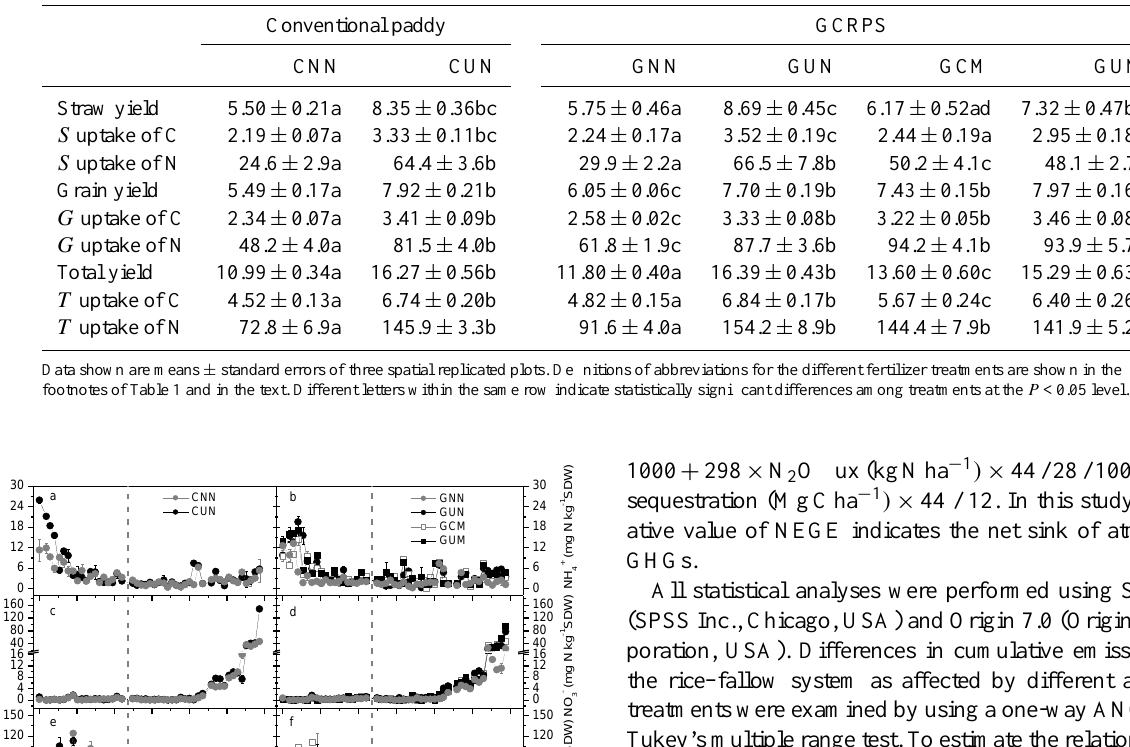
Table 2. Straw ( S ) and grain ( G ) yields as well as total ( T ) yields (straw and grain, in Mgha − 1 ) , and plant uptake of C (in Mgha − 1 ) and N (in kgha − 1 ) at physiological maturity for different fertilizer treatments in the conventional paddy and ground cover rice production systems (GCRPS).